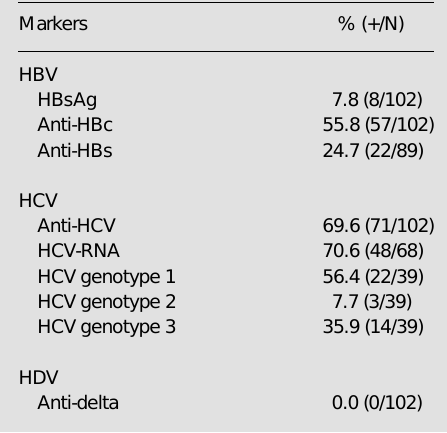
Table 2 - Percent frequency and numerical data for samples testing positive (+)/samples (N) tested for different viral hepatitis serological markers among IDUs from Rio de Janeiro, Brazil (1994- 1996).